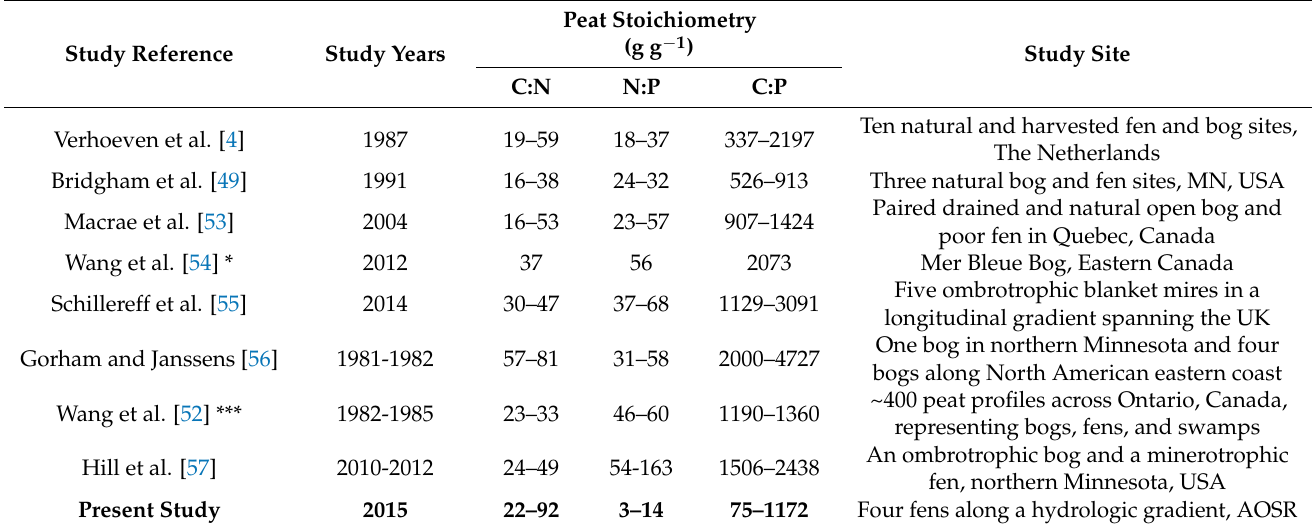
Table 5. Nutrient stoichiometry of the studied peatlands in the Athabasca Oil Sands Region with comparable peatland sites, representing entire-core data. Ranges are shown when explicitly available in paper; otherwise; means of a single or multiple sites are given, indicated by * or ***,